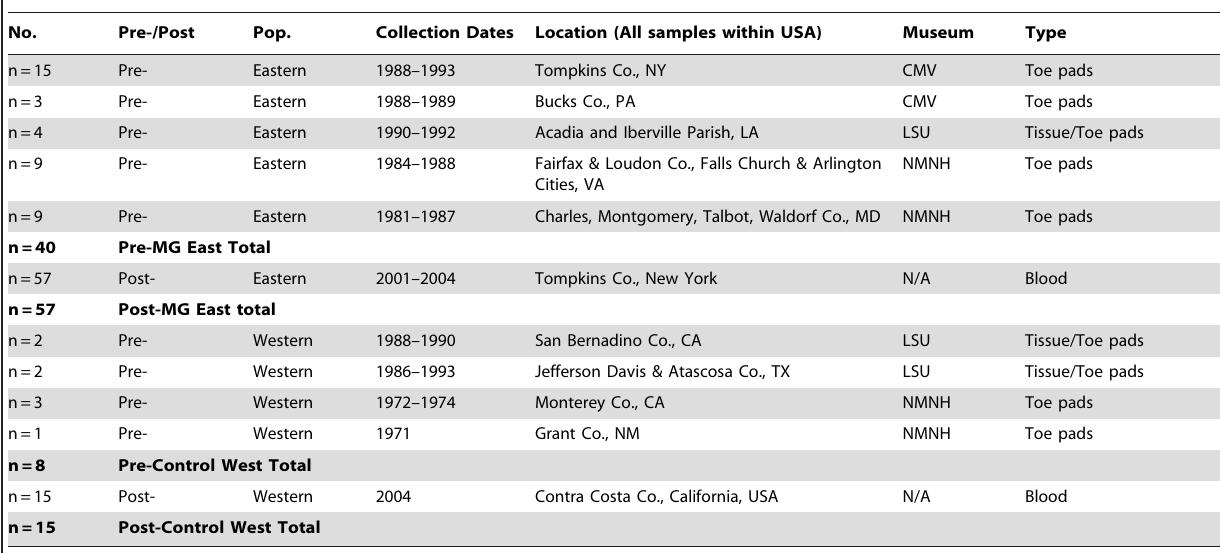
Table 1. Sampling information for all house finches included in the